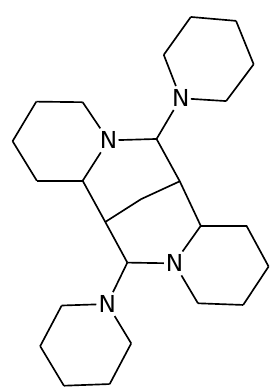
Scheme 2. Structural formula of 6,13-di(piperidin-1-yl)dodecahydro-2 H ,6 H -7,14-methanodipyrido[1,2- a :1',2'- e ][1,5]diazocine, polycyclic piperidine derivative ( 10